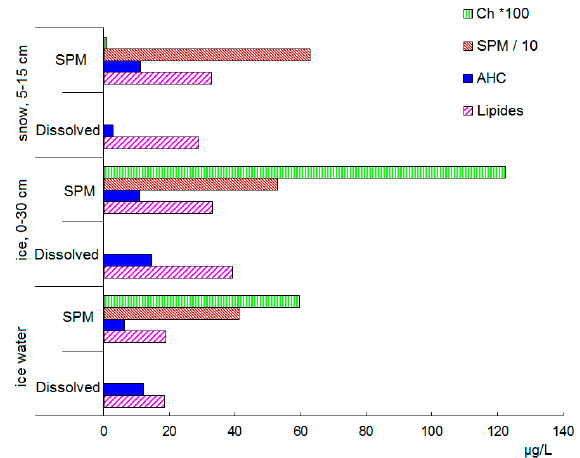
Figure 14. Changes in the concentrations of organic compounds and suspensions in the snow-ice cover of Stepped Lake in 2012.